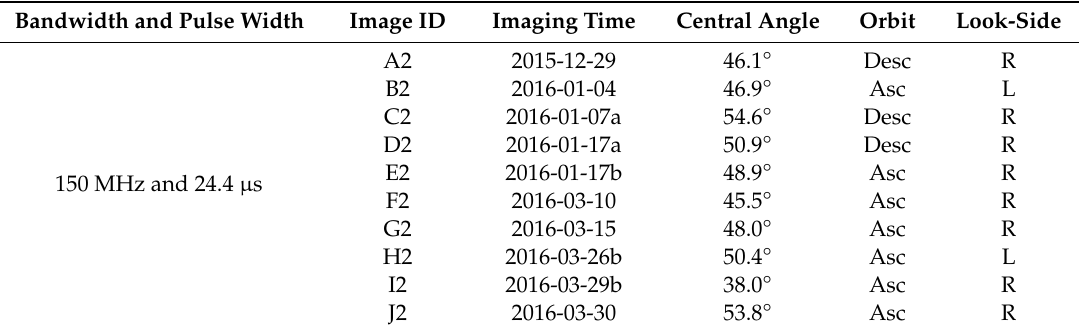
Table 2. Calibration Group B image data.